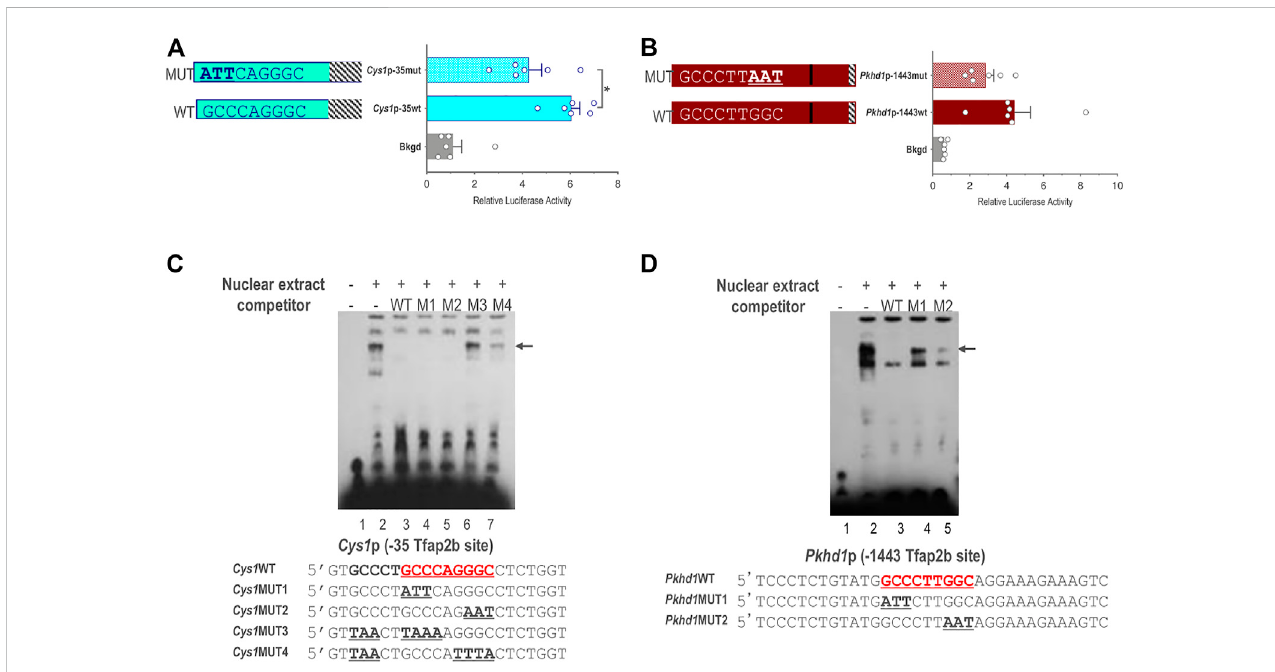
FIGURE 5 Endogenous TFAP2B binding to sites in Cys1 and Pkhd1 promoters. (A) Luciferase activity in mIMCD-3 cells transfected with Cys1 p-35 reporter constructs bearing either WT or mutant versions of the proximal Cys1 TFAP2B consensus binding site. (B) Luciferase assays in cells transfected with Pkhd1 p- 1443 reporter constructs with either WT or mutant forms of the distal Pkhd1 TFAP2B binding site. (C and D) EMSA analysis comparing competitive binding of nuclearextracttoWTvs.mutantformsofthe Cys1 p-35 (C) and Pkhd1 p-1443 (D) TFAP2Bsite.WTTFAP2Bbindingsiteandmutatedbpareshowninbold and underlined typeface. Arrows indicate shifted bands of interest. The error bar indicates S.E.M.; * indicates p <